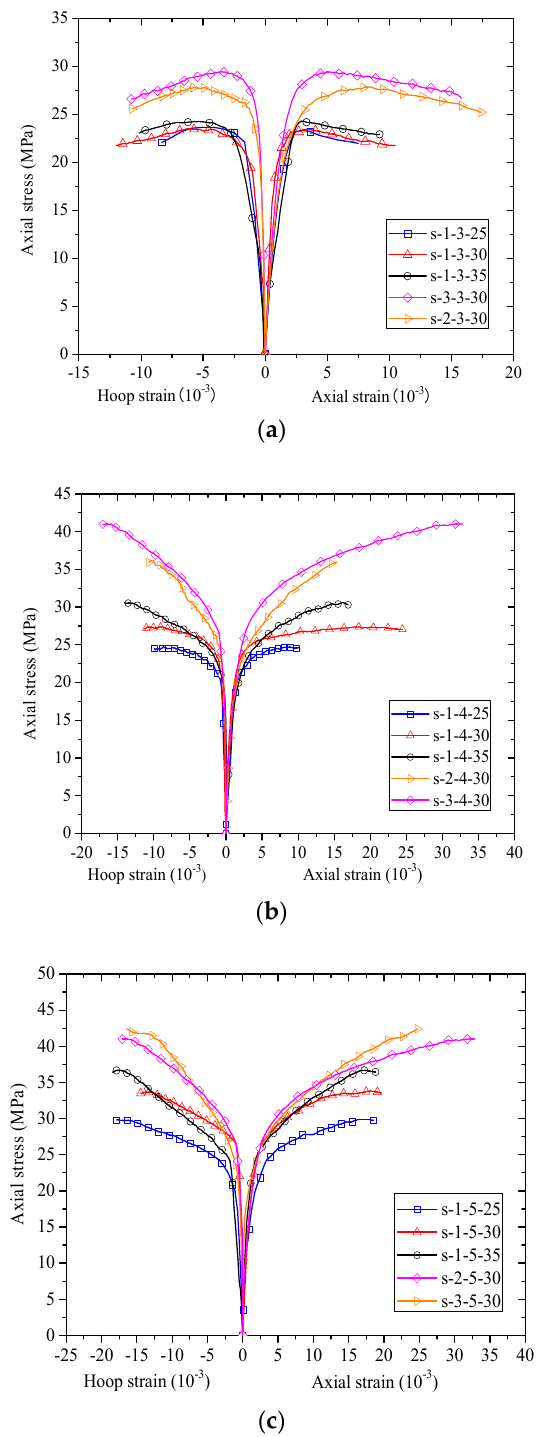
Figure 9. Stress-strain curves. ( a ) Specimens wrapped with three strips; ( b ) Specimens wrapped with four strips; ( c ) Specimens wrapped with five strips.